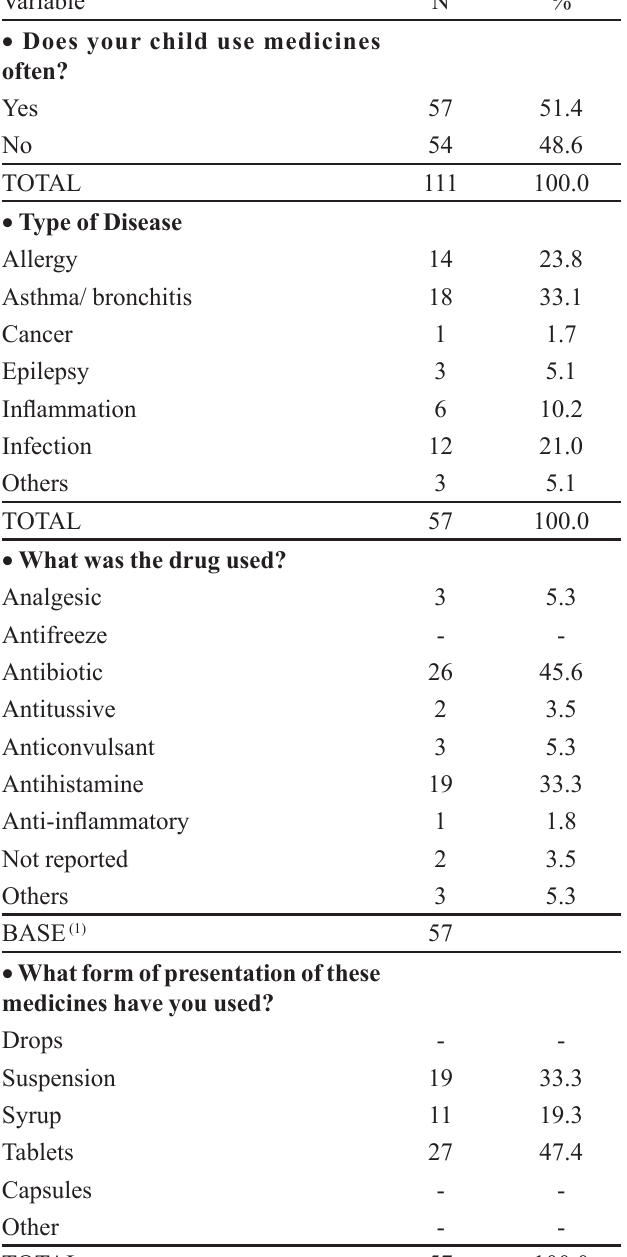
TABLE I - Sample Distribution by sociodemographic variables Variable